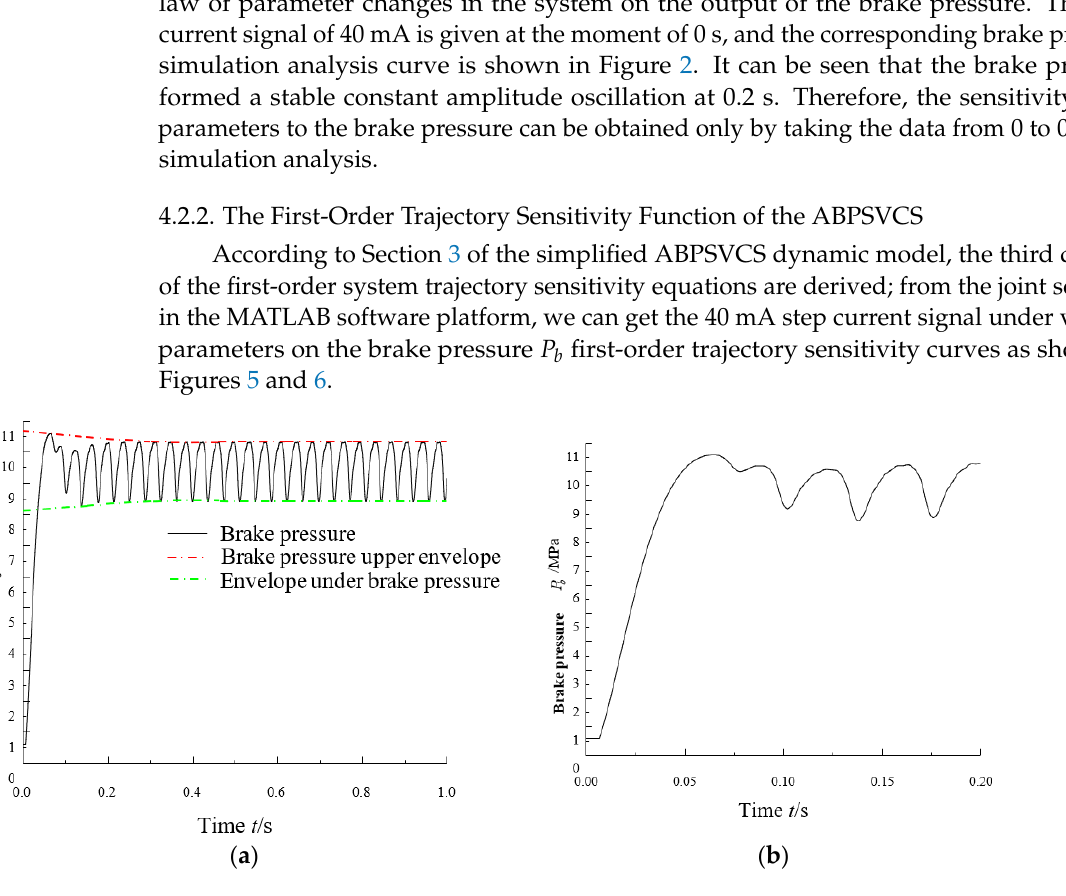
Figure 5. the solving conditions of first-order trajectory sensitivity. ( a ) Brake pressure response under 40 mA step, ( b ) 0~0.2 step response waveform of brake pressure.